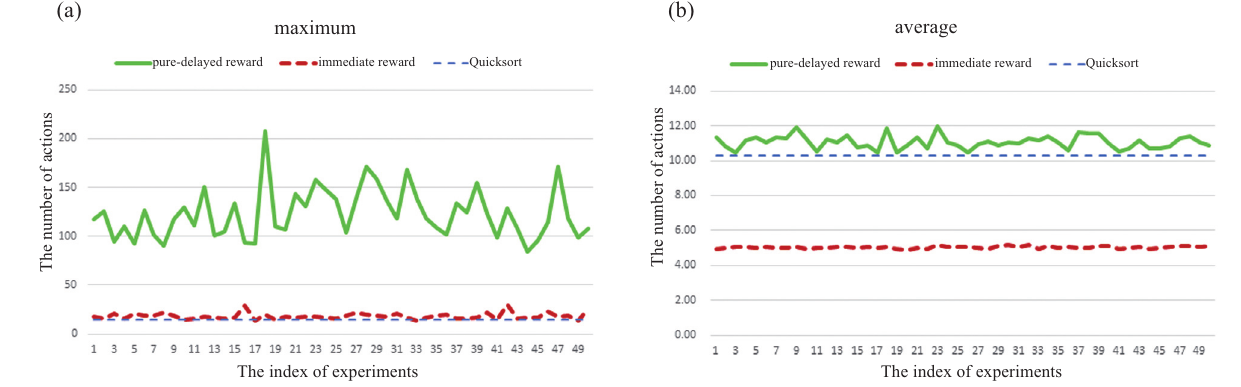
Fig. 5. Detailed results of maximum (a) and average (b) values to sort 6! lists for 50 times regarding pure­delayed reward, immediate reward, and